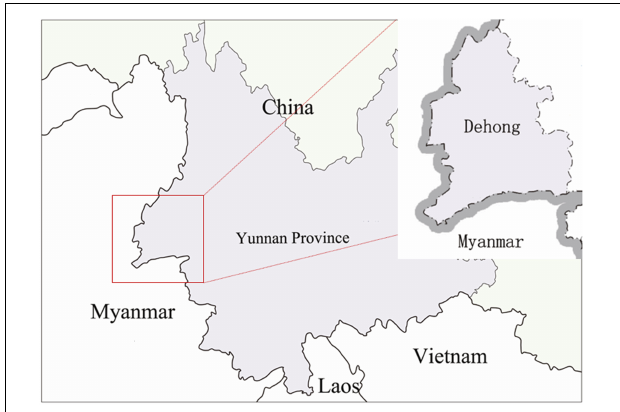
FIGURE 1 | Study site location at the China-Myanmar border. The black dotted line with a gray shadow shows the border between China and Myanmar, and the light purple area indicates the region of Yunnan Province. The red box indicates our study site. Magnified images of boxed areas are shown in the upper right